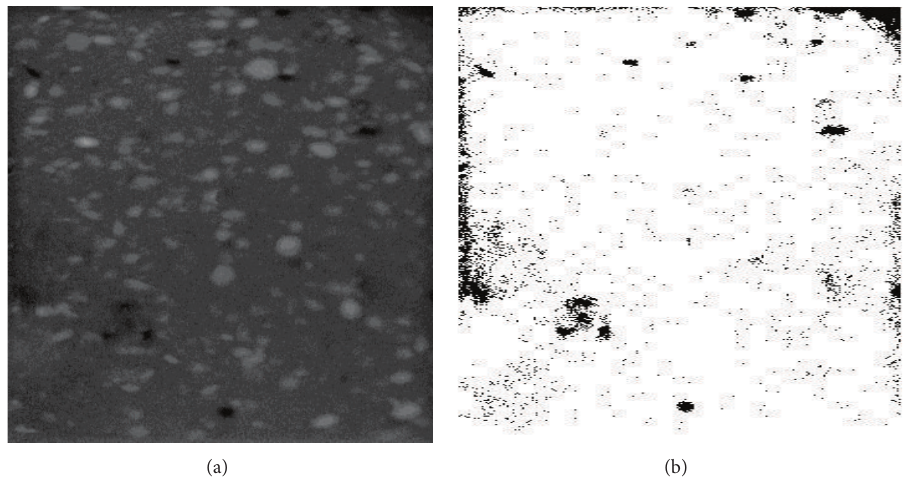
Figure 2: Mixing image and binary image in electrodeposition.